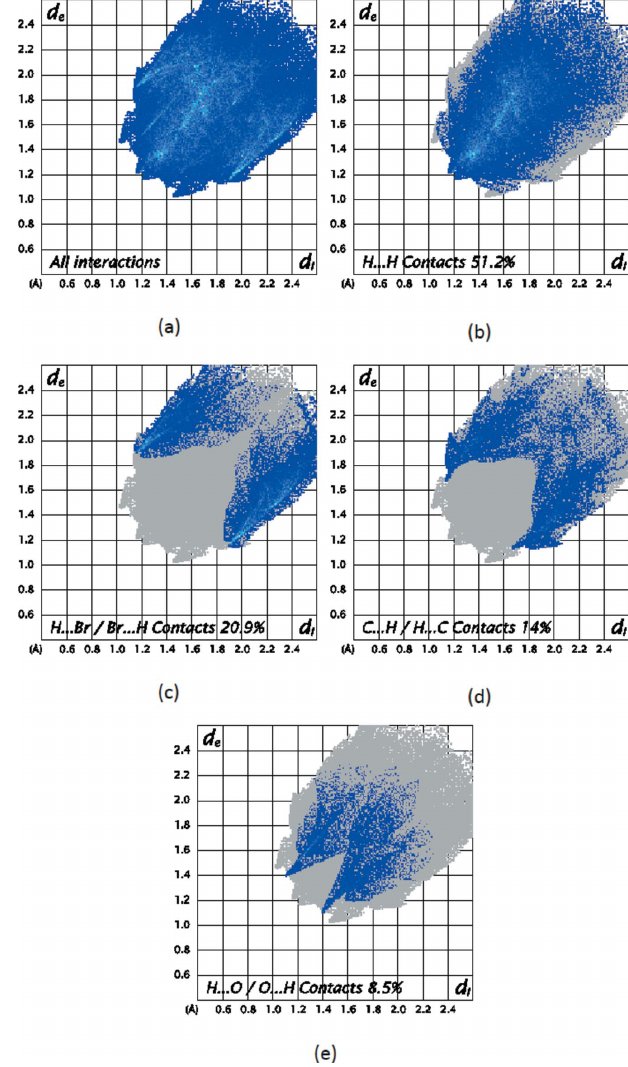
Figure 9 Two-dimensional fingerprint plots for compound (II), showing ( a ) all interactions, and delineated into ( b ) H (cid:2)(cid:2)(cid:2) H, ( c ) Br (cid:2)(cid:2)(cid:2) H/H (cid:2)(cid:2)(cid:2) Br, ( d ) C (cid:2)(cid:2)(cid:2) H/H (cid:2)(cid:2)(cid:2) C and ( e ) O (cid:2)(cid:2)(cid:2) H/H (cid:2)(cid:2)(cid:2) O interactions. The d i and d e values are the closest internal and external distances (in A˚ ) from given points on the Hirshfeld